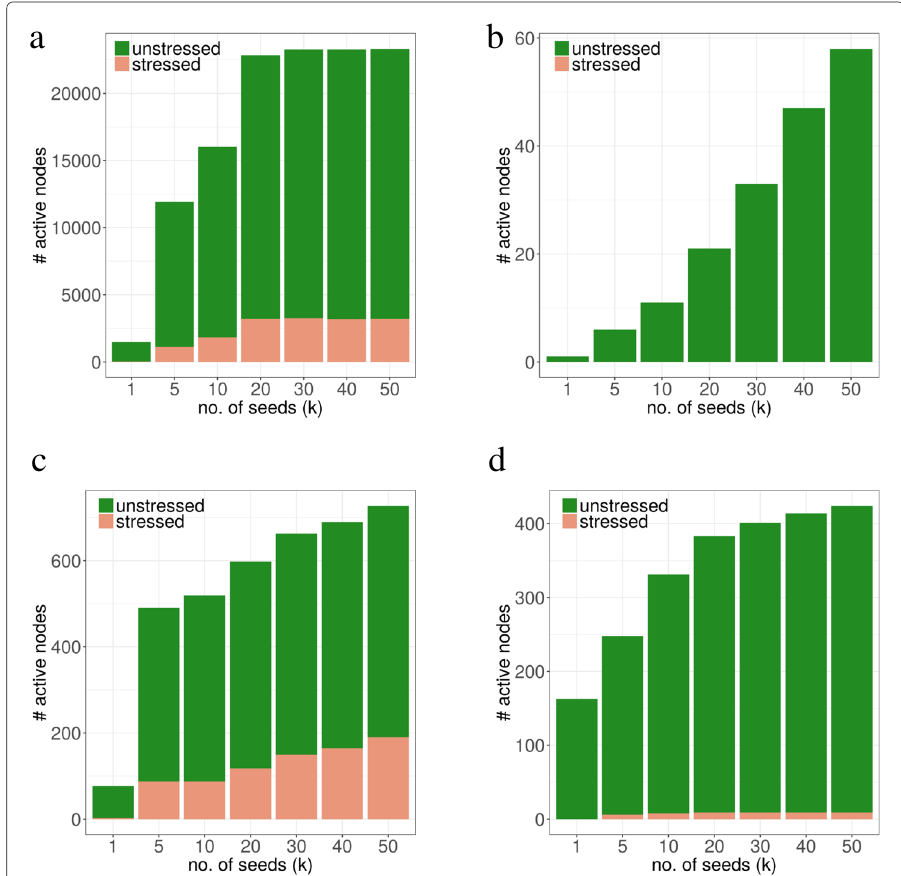
Fig. 10 Spread of nC - F 2 DLT by varying seed set size ( k ) and selection strategy. a Epinions, I-Sources. b Slashdot, M-Sources. c Wiki-Vote, Stress-Triads. d Wiki-Conflict,